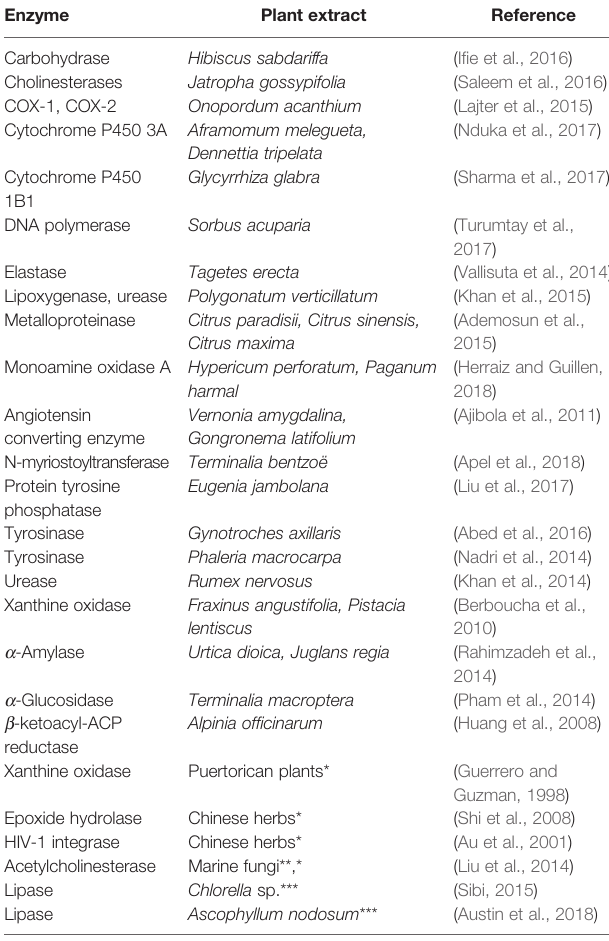
TABLE 1 | Some examples of enzyme inhibiting extracts from natural